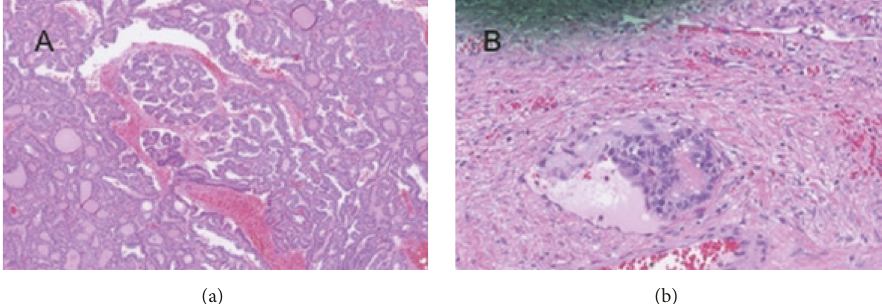
Figure 1: (a) Papillary thyroid carcinoma arising in struma ovarii. (b) Vascular invasion of malignant struma